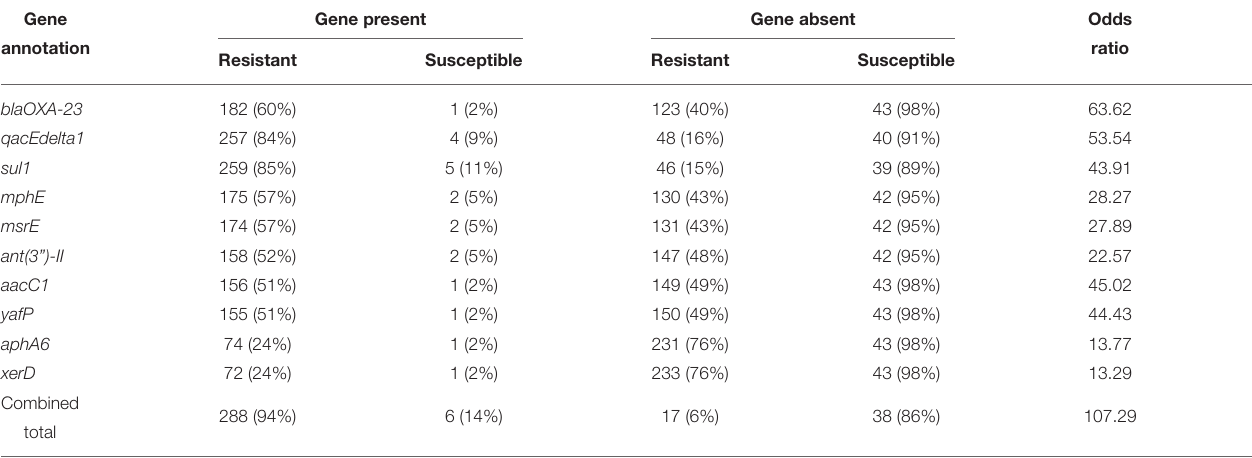
TABLE 2 | Ten known antimicrobial resistance (AMR) genes strongly associated with imipenem-resistance in 349 A. baumannii genomes analyzed ( p ≤ 0.01, Fisher’s exact test) and present infrequently in imipenem-susceptible isolates ( ≤ 10 out of 44). Gene annotation